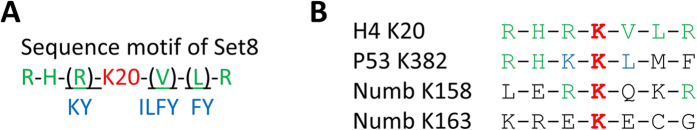
Peptide substrate sequence motif of SET8 and sequence alignment of histone H4, p53 and Numb target lysines.(A) The substrate specificity profile of SET8 was adopted from Kudithipudi et al. (2012)13. The upper row represents the amino acid sequence of the H4 tail surrounding K20 (printed in green), the lower row specifies the other amino acids that are also accepted at the corresponding position (printed in blue). (B) Sequence alignment of the H4, p53 and Numb target lysine residues. The target lysine is in red. Green and blue coloring is as indicated in A.